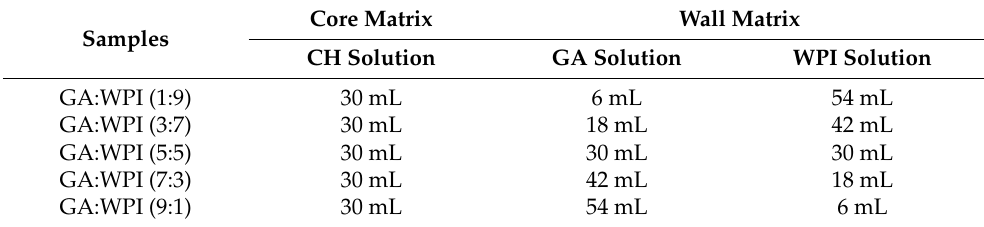
Table 1. The blending procedure of core matrix and wall matrix